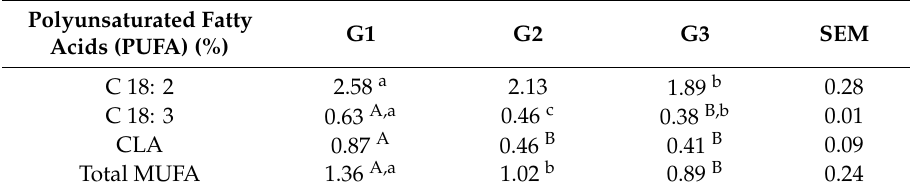
Number of fatty acids in sheep’s milk during the lactation—column header; G1—Group lambing in February (milked from April to August)–column header; G2—Group lambing in June (milked from August to October)–column header; G3—Group-lambing in June (milked from August to November and melatonin-treated before 6 weeks parturition)–column header; a,b,c —means within a row with di ff erent lowercase superscripts di ff er significantly